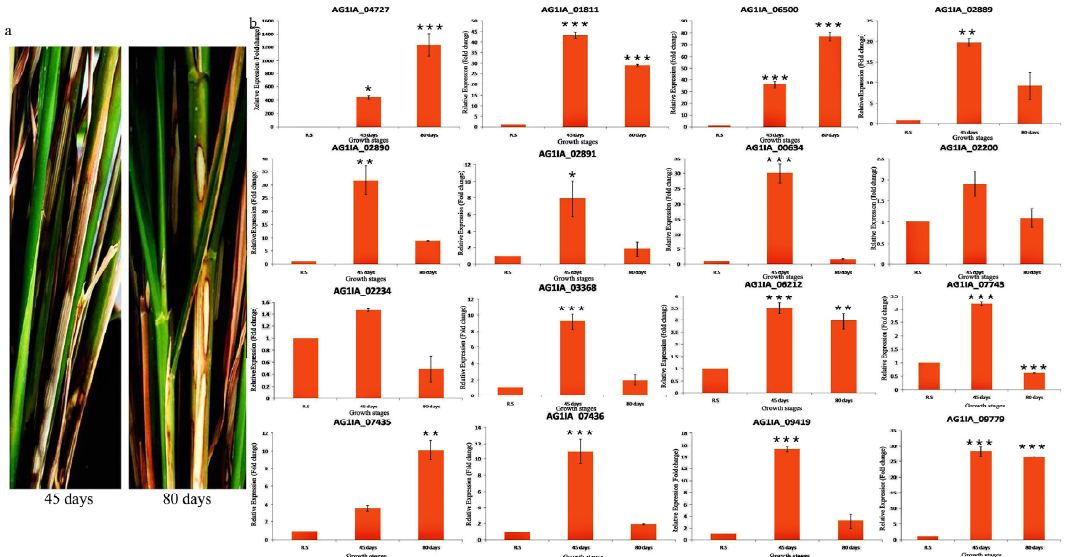
Figure 9. ( a ) The sheath blight disease symptoms on 45 days and 80 days old TN1 plants upon inoculation of R. solani Wgl-2. ( b ) qRT-PCR expression analysis of 16 PD genes (polygalacturonases and pectinesterases) in sheath tissue of 45 days and 80 days old TN1 plants after R. solani inoculation. X-axis: samples; Y-axis: Expression level of the individual PD genes relative to their expression in R. solani grown in PDA. Error bars indicate the mean ± S.E. of three biological replicates. Statistical significance was determined by performing one-way ANOVA analyses followed by a Tukey’s test (* = p < 0.01, ** = p < 0.001, and *** = p <